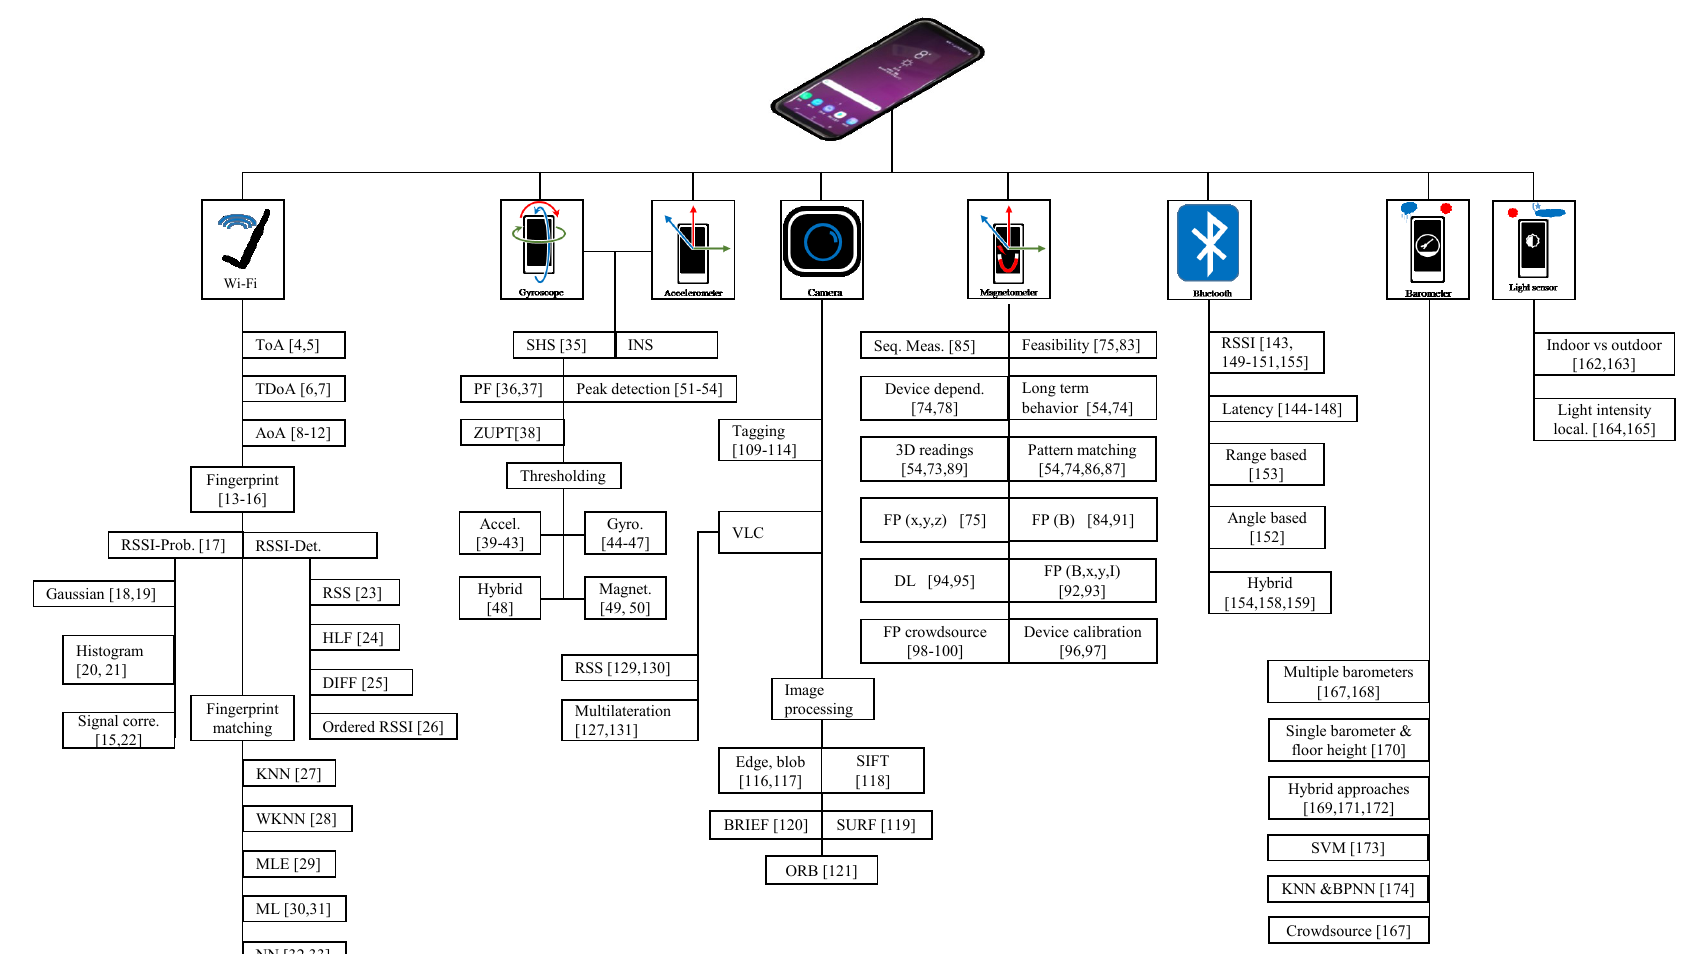
Figure 10. List of the approaches discussed in the paper against each smartphone